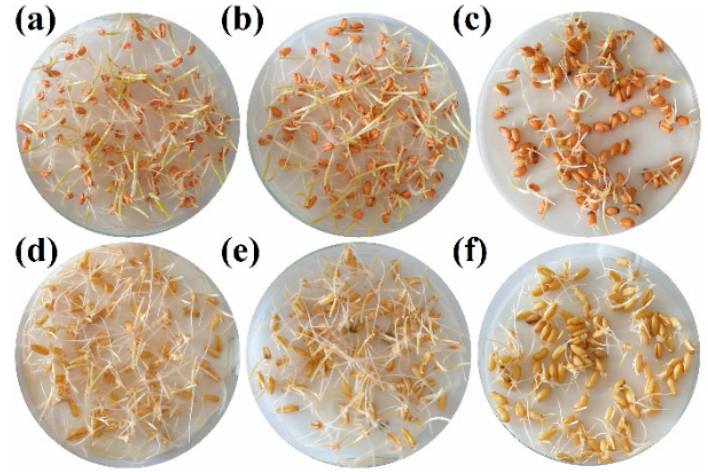
Figure 4. Germination tests for winter wheat seeds—( a ) negative control; ( b ) treated seeds; ( c ) positive control—and Kamut seeds—( d ) negative control; ( e ) treated seeds; ( f ) positive control—. Only one replicate is shown.